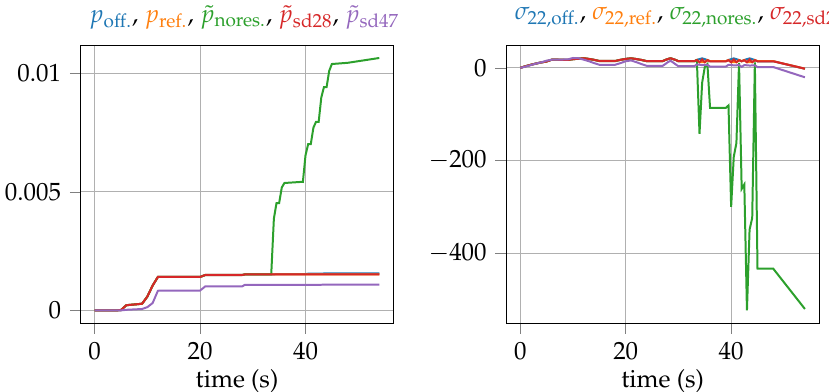
Figure 12. ( top ) Diverse HF and ROM dual quantity fields at t = 43.5 s for subdomain 28, ( left ) p , ( right ) σ 22 ; ( bottom ) comparison at the point identified by the green arrow on the top-left picture. The components of the stress tensor are in MPa.